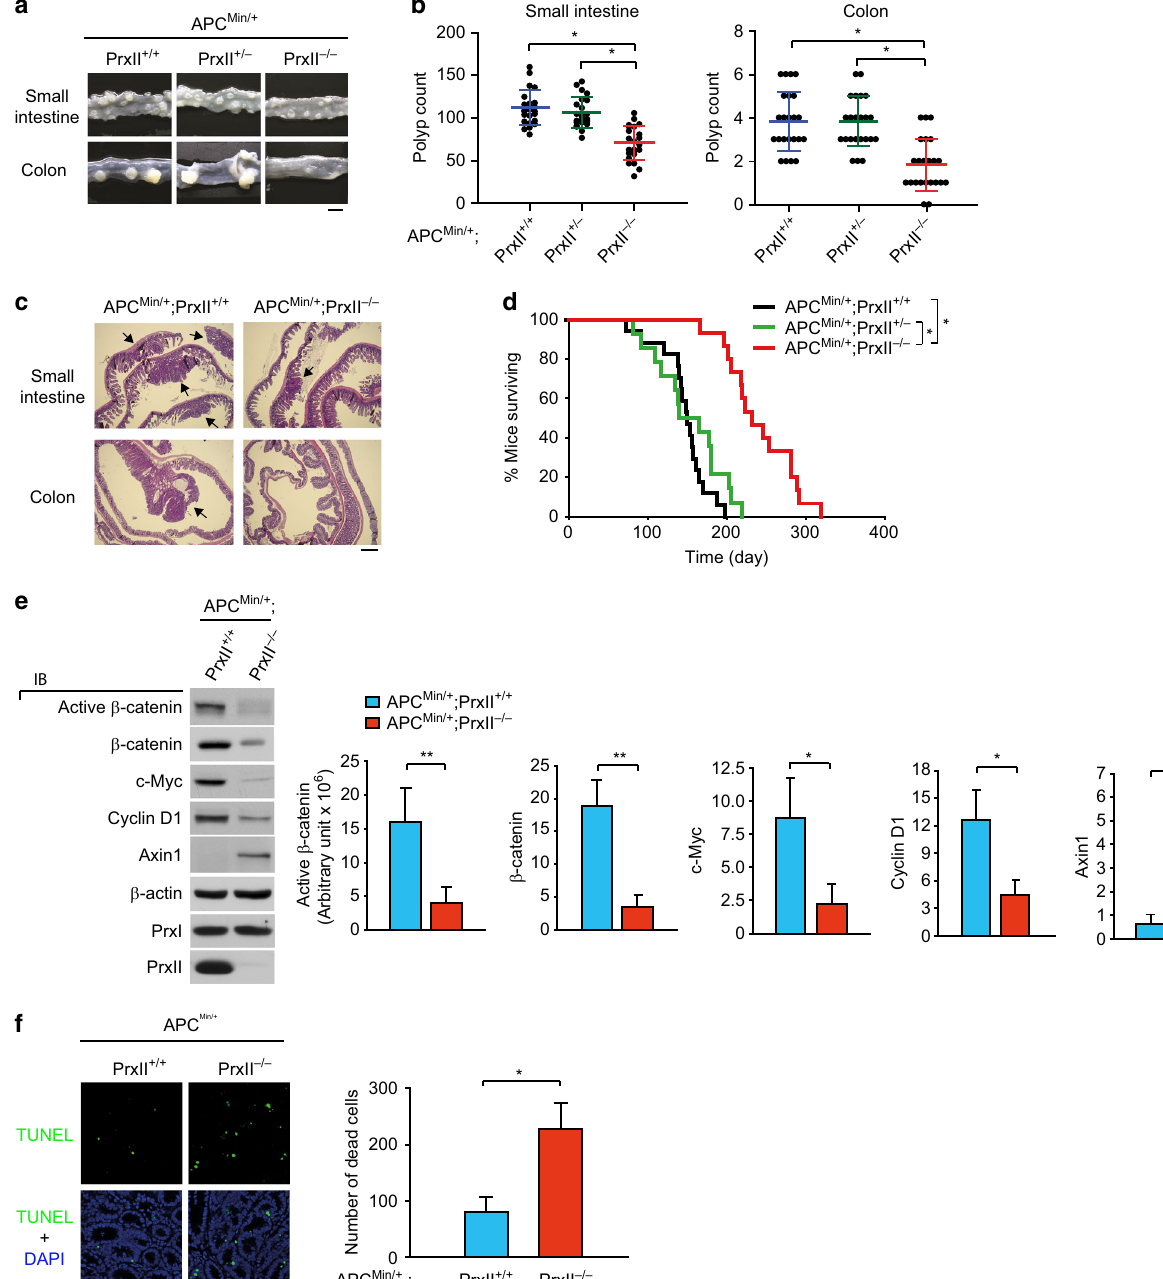
Fig. 1 Loss of PrxII suppresses intestinal tumorigenesis and increases survival in APC-mutant mice. a Representative photomicrographs of longitudinally opened intestinal tissues from APC Min/ + ;PrxII + / + , APC Min/ + ;PrxII + / − , and APC Min/ + ;PrxII − / − mice. Scale bar, 5 mm. b Macroscopic polyps ( > 3 mm in diameter) were counted in whole-mount intestinal tissues from APC Min/ + ;PrxII + / + , APC Min/ + ;PrxII + / − , and APC Min/ + ;PrxII − / − mice. Dot plots represent the average polyp numbers ± s.d. ( n = 23 mice per group, * P < 0.001 with repeated-measures ANOVA). c Cross sections of frozen small intestines and colons from APC Min/ + ;PrxII + / + and APC Min/ + ;PrxII − / − mice were stained by hematoxylin and eosin. Arrows indicate the polyps. Scale bar, 1 mm. d Kaplan – Meier plot showing the survival of APC Min/ + ;PrxII + / + ( n = 17), APC Min/ + ;PrxII + / − ( n = 14), and APC Min/ + ;PrxII − / − ( n = 15) mice (* P < 0.001 with Log rank test). e Intestinal polyps from APC Min/ + ;PrxII + / + and APC Min/ + ;PrxII − / − mice were homogenized and immunoblotted (IB) for indicated proteins. Data in the graph are means ± s.d. of the intensities of immunoreactive bands after being normalized with control β -actin level ( n = 3, * P < 0.05, ** P < 0.01). f Cell death in the intestinal polyps from APC Min/ + ;PrxII + / + and APC Min/ + ;PrxII − / − mice was measured by TUNEL staining. Nuclei were stained with DAPI. Data in the graph are means ± s.d. of the number of TUNEL-positive cells per mm 2 ( n = 9 mice per group, * P < 0.01). Scale bar, 50 μ